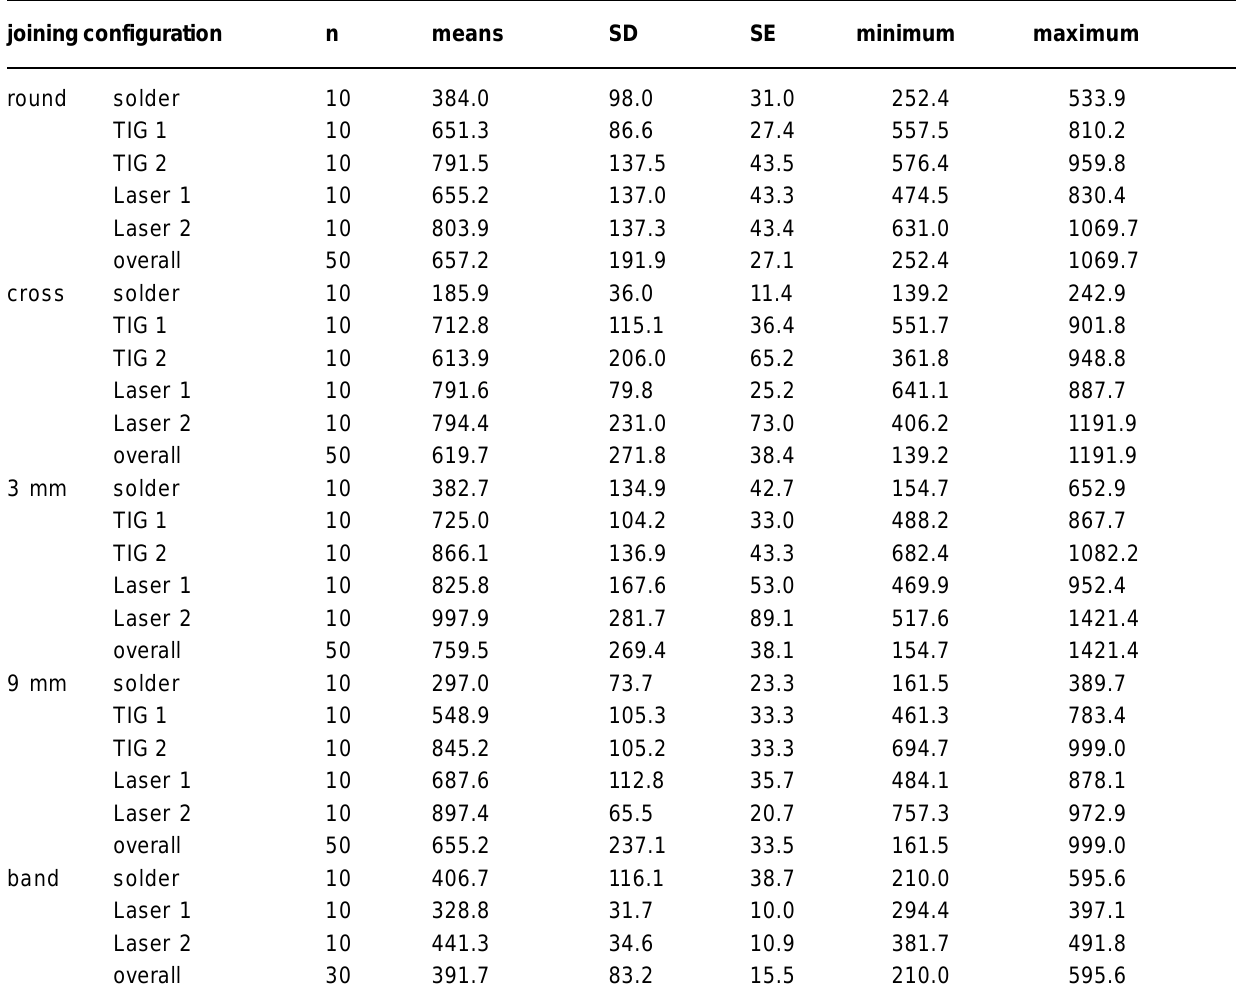
TABLE 4- Fracture strength means in joining configuration